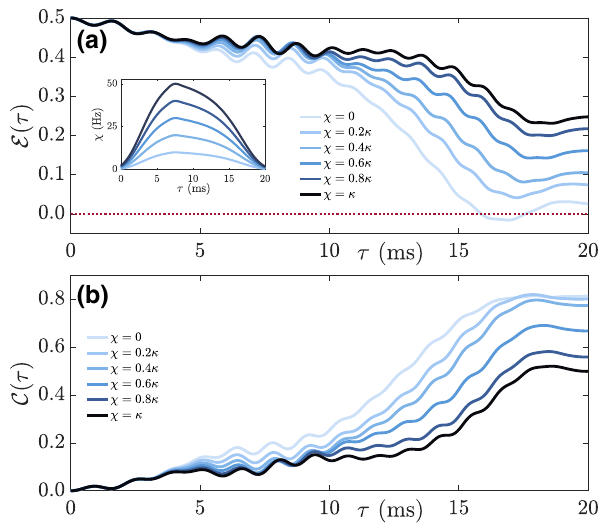
FIG. 4. (a) Time evolution of the electric flux E (τ) , defined in Eq. (12a), throughout the ramp protocol of Fig. 3. The param- eter χ is tuned in such a way that χ/κ is constant throughout the ramp (see inset), taking into account the corresponding varia- tion of κ during the ramp. The order parameter reaches zero only in the case of χ = 0 where Coleman’s phase transition exists in the deconfined regime, while it is always finite throughout the entire duration in the ramp when χ (cid:15)= 0, since then the associ- ated global Z 2 symmetry is explicitly broken in this confined regime, lifting Coleman’s phase transition. (b) Time evolution of the chiral condensate C (τ) , defined in Eq. (12b), through- out the ramp protocol of Fig. 3. The vacuum state is void of matter, so naturally C ( 0 ) = 0. In the deconfined regime ( χ =